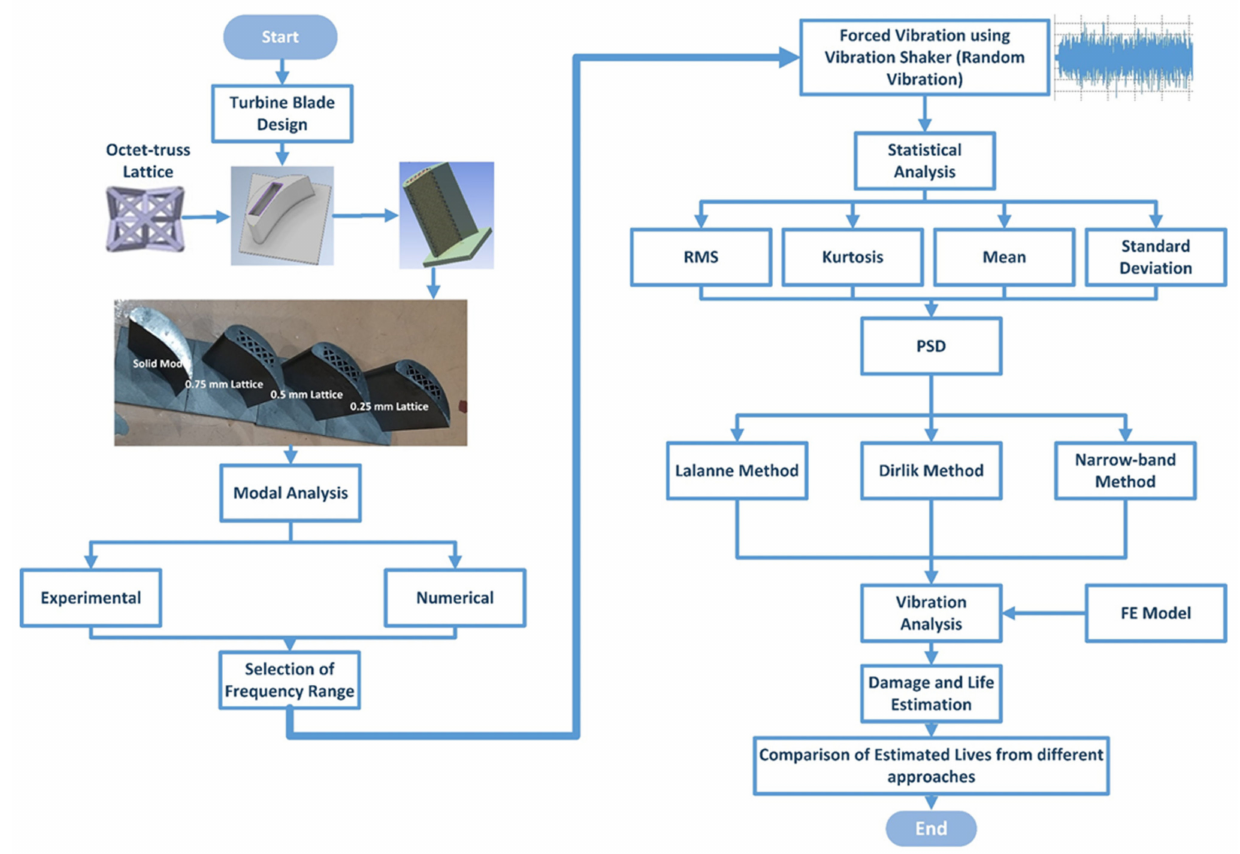
Figure 1. Research